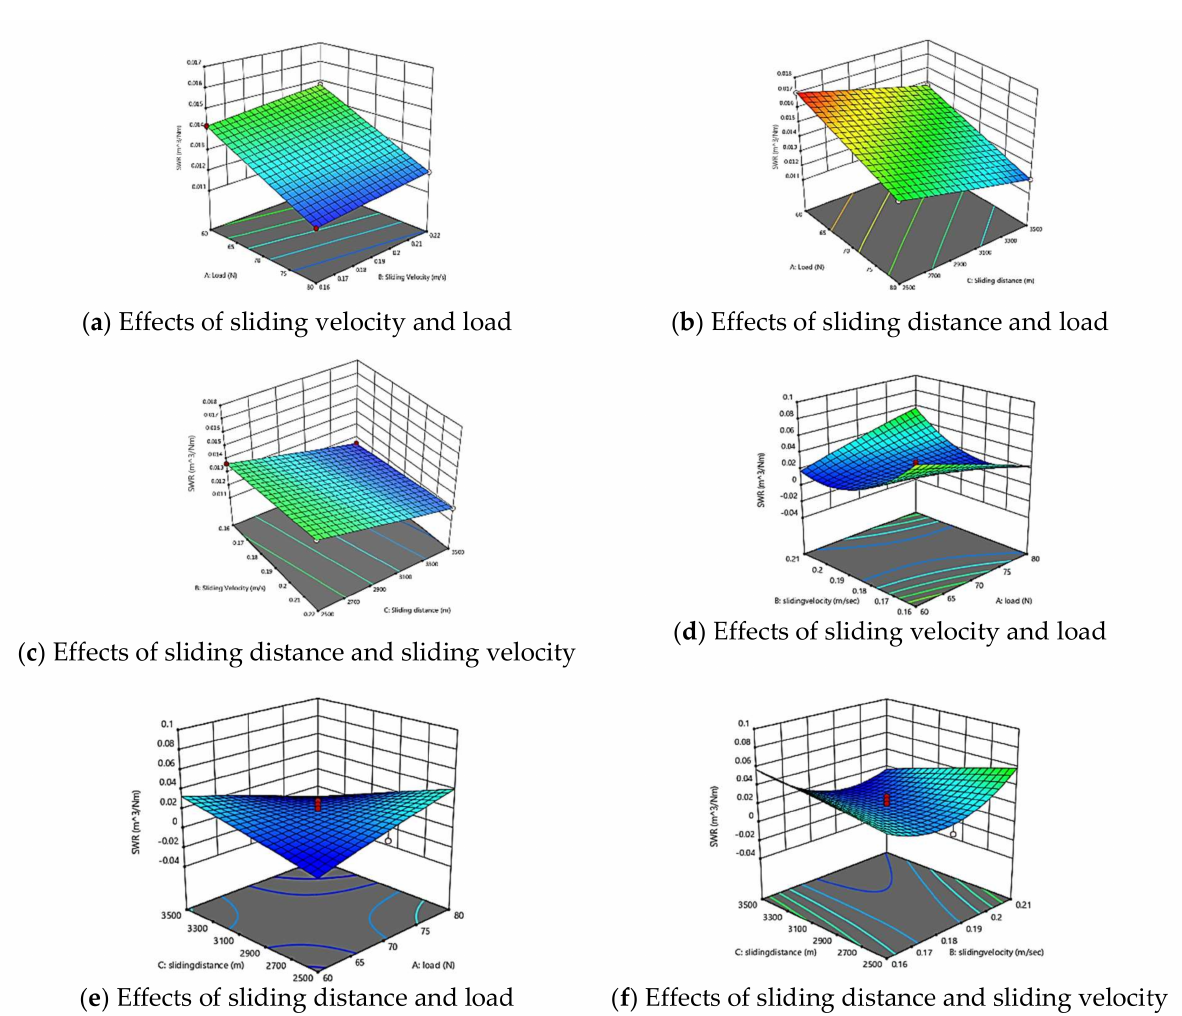
Figure 7. 3D surface of SWR model GFRPA66 30 wt.% and GFRPA66 35 wt.%; ( a ) GFRPA66 30 wt.% effects of sliding velocity and load, ( b ) GFRPA66 30 wt.% effects of sliding distance and load, ( c ) GFRPA66 30 wt.% effects of sliding distance and sliding velocity, ( d ) GFRPA66 35 wt.% effects of